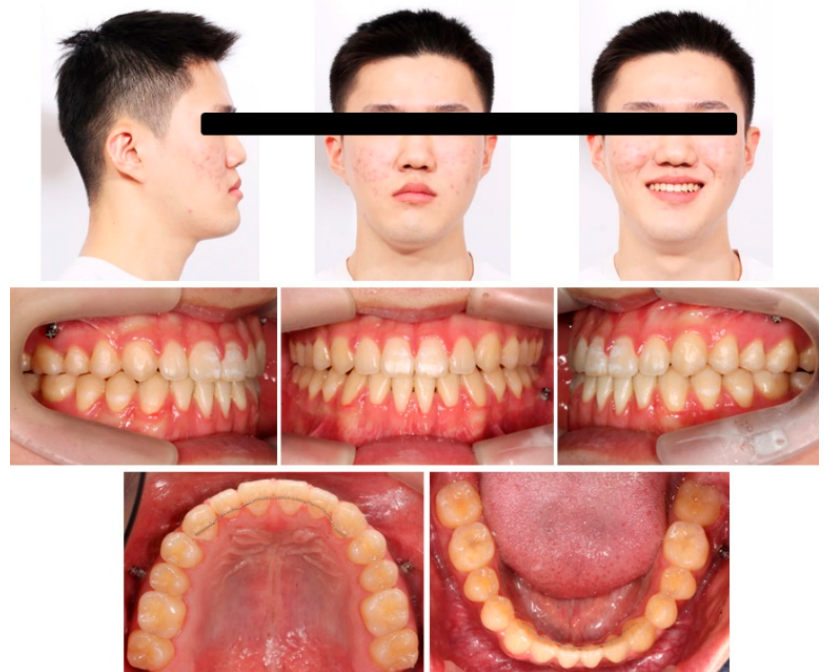
Figure 9. Pos tt reatment facial and intraoral photographs.